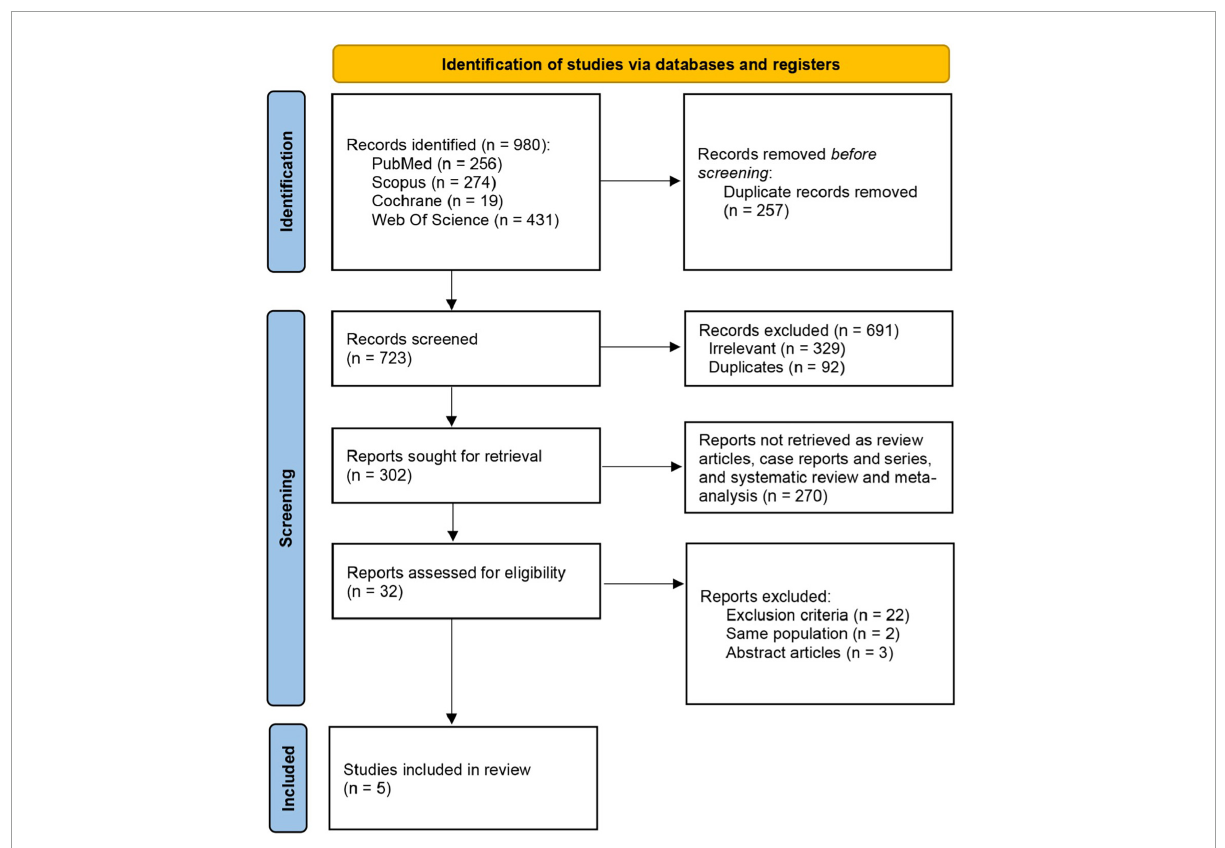
FIGURE1 Flow chart of studies identified, screened, and included in the